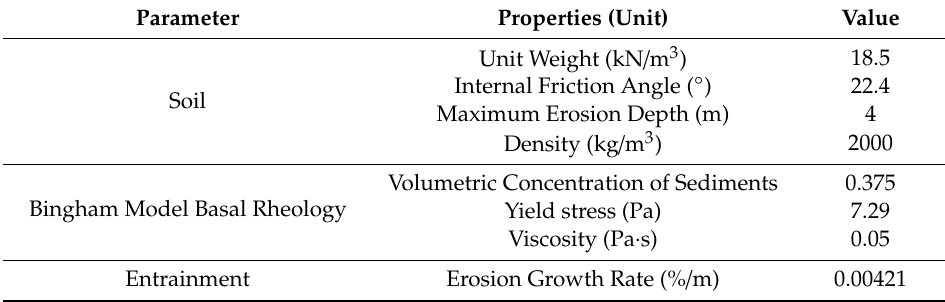
Figure 12. The Surfer grid files used for DAN3D that provide the following information: ( a ) path topography, ( b ) initial source, and ( c ) erosion map for the Raemian region [16]. Table 1. The input values used in DAN3D for simulating debris-flow at Umyeon mountain [16].